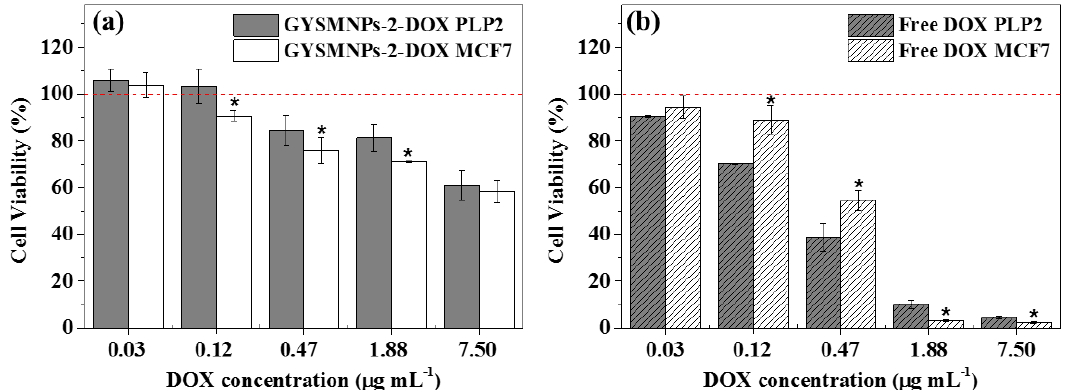
Figure 8. The in vitro cellular drug-delivery assays for several DOX concentrations, following 48 h of incubation. ( a ) GbMNP-2-DOX growth inhibition results tested in cancer cell line (MCF-7) and healthy cell line (PLP2); ( b ) free DOX growth inhibition results tested in the MCF-7 and PLP2 cell lines. Error bars represent a 95% confidence interval and the asterisks (*) represent statistical significance in comparison with a healthy cell line, PLP2, for p < 0.05 determined by the Student’s t -test.